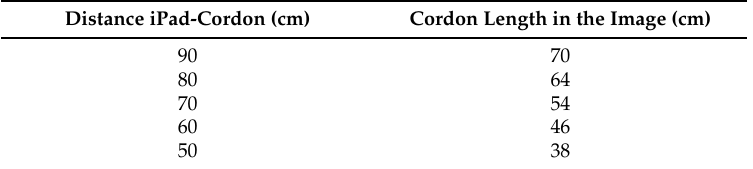
Table 1. Relationship between the distance of the device (iPad 4) from the vine’s cordon and the length of cordon included in the image considering the iPad4’s camera field of view of 43 ˝